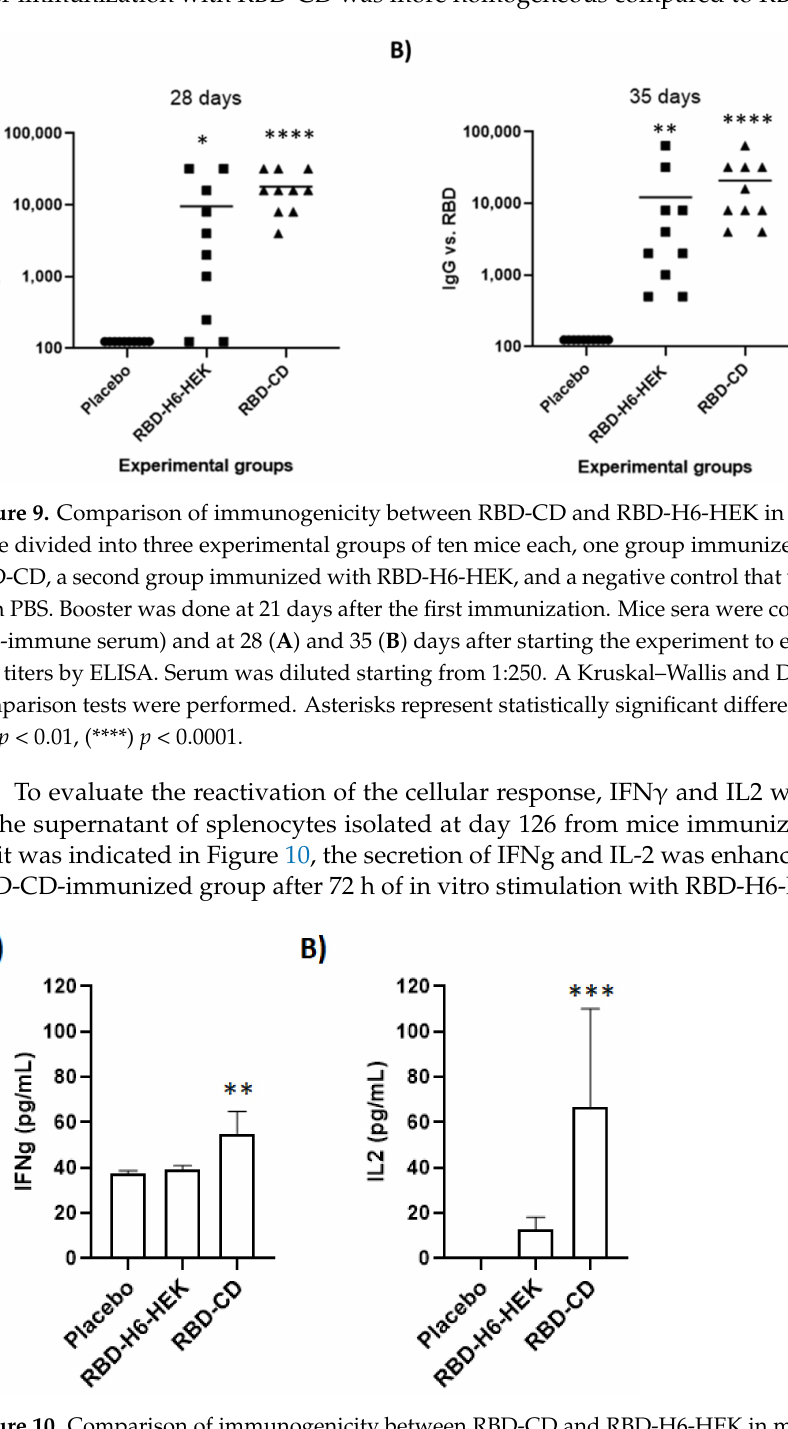
Figure 10. Comparison of immunogenicity between RBD-CD and RBD-H6-HEK in mice. To evaluate the reactivation of the cellular response, the mice received a booster at day 112 and 14 days later, 5 animals from each group were sacrificed and the spleens were extracted under aseptic conditions. The cells (2 × 10 5 cells per well) were seeded in 96-well round-bottom tissue culture plates in RPMI- 1640 medium. The cells were stimulated for 72 h with RBD-H6-HEK at 10 µ g/mL. Concanavalin A (Sigma-Aldrich, USA) at 5 µ g/mL was used as the assay positive control. The supernatants of splenocytes previously stimulated were analyzed by ELISA for mouse ( A ) IFN γ and ( B ) IL-2. (**) p < 0.01, (***) p <